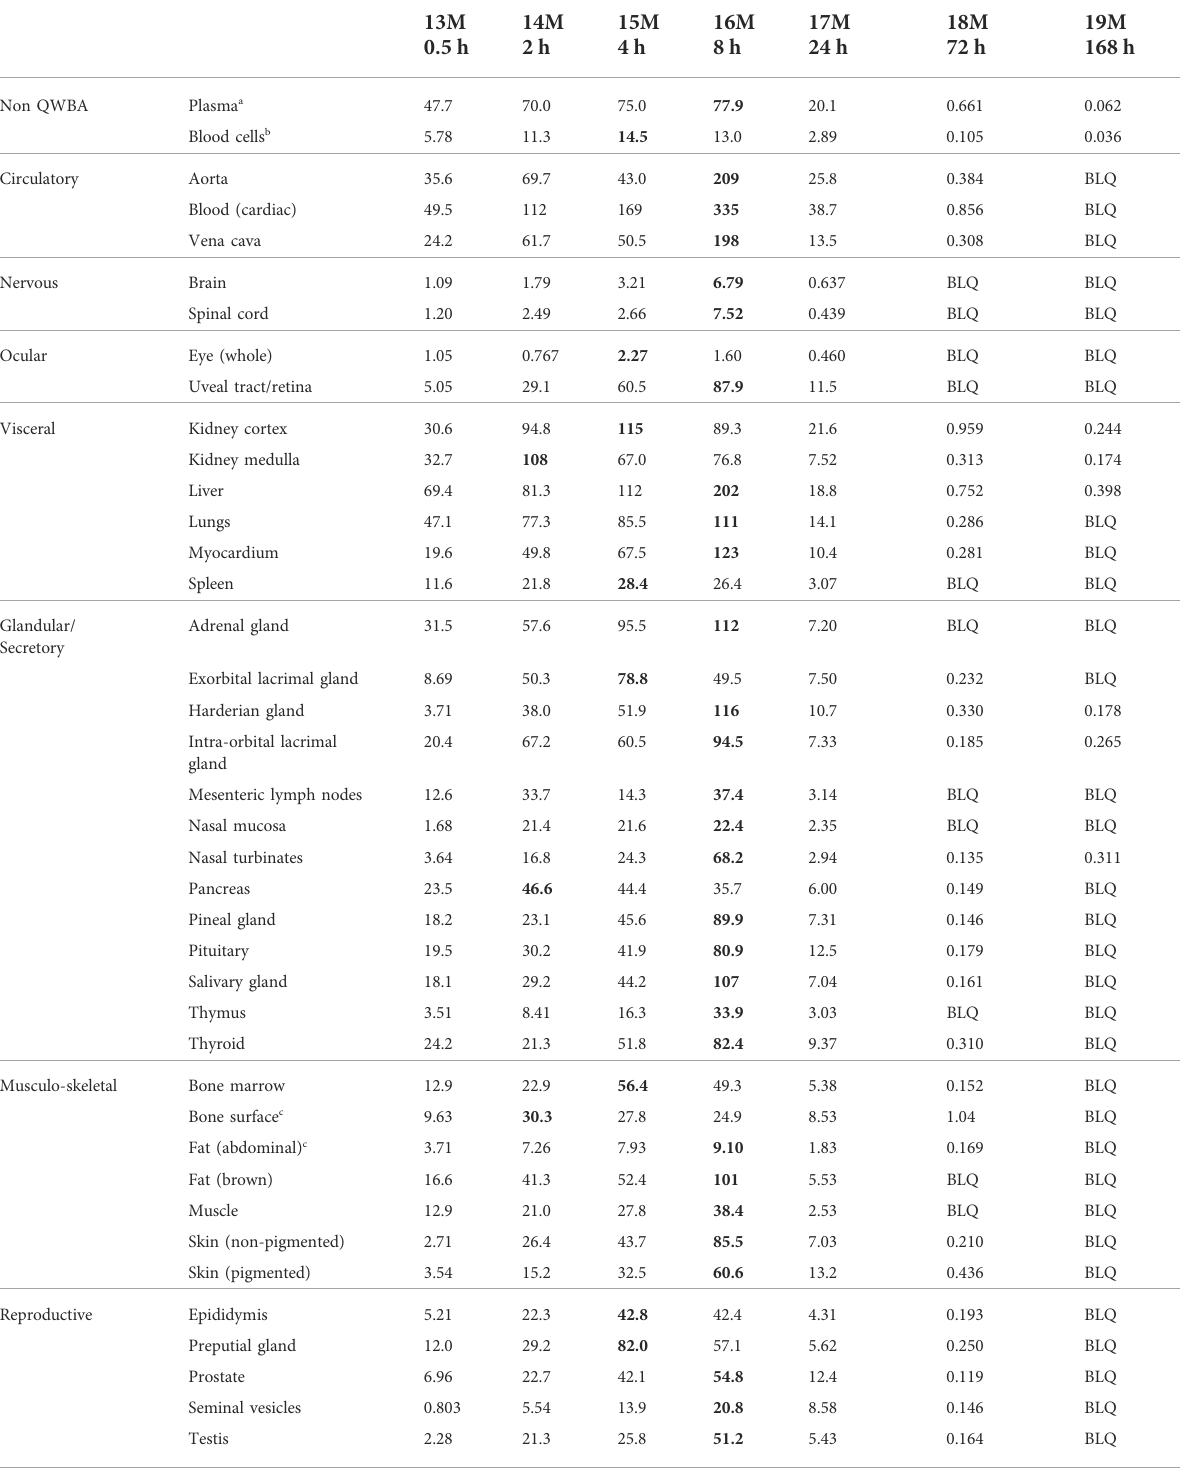
TABLE 5 Concentrations of radioactivity in tissues determined by QWBA following a single oral administration of [ 14 C] zapnometinib (30 mg/kg) to male partially pigmented rats (Group 3). Tissue